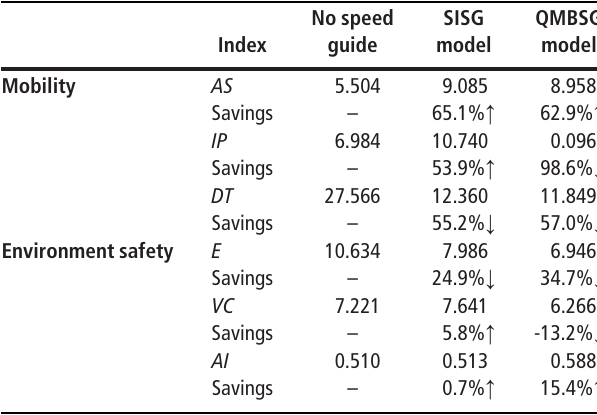
Table 5 Quantitative comparison of the six indexes of the two models